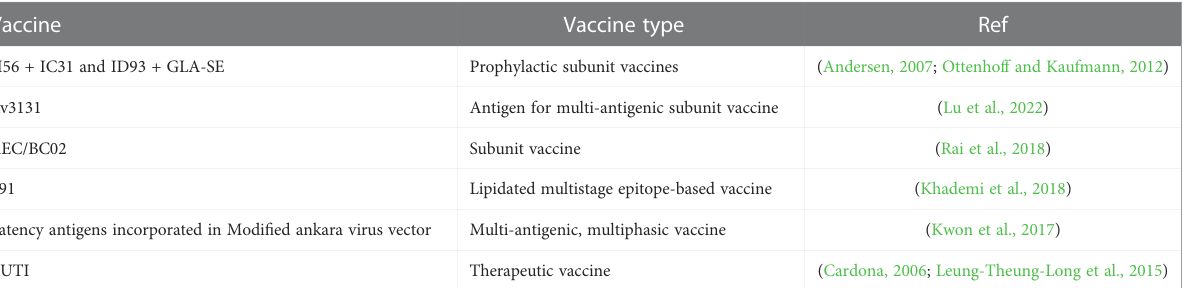
TABLE 3 List of vaccines currently under study against dormant M.tb